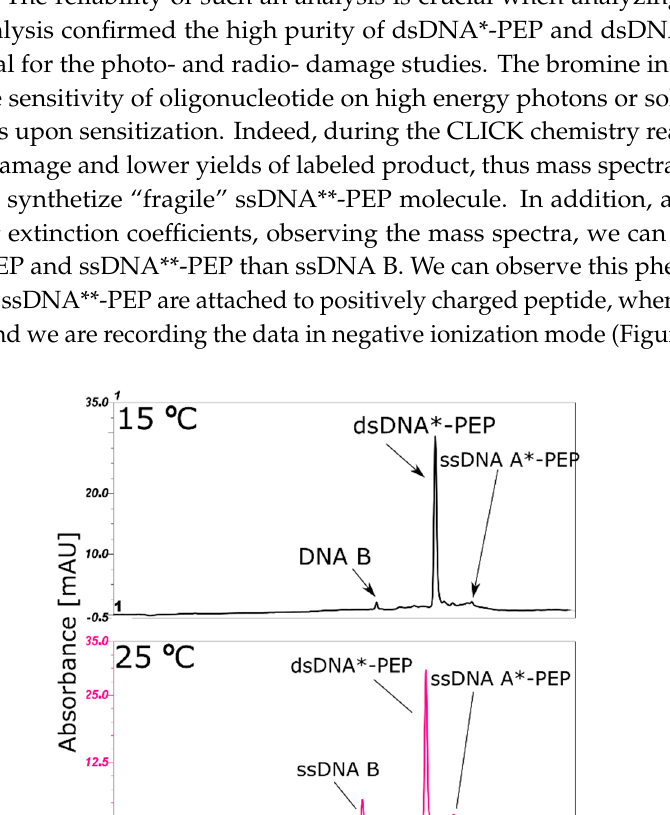
Figure 4. HPLC analysis of the dsDNA*-PEP product obtained after annealing ssDNA A*-PEP peptide conjugates, showing a decrease in the ssDNA form at a lower temperature suggesting the interaction between ssDNA B complementary strand do ssDNA A*-PEP. HPLC conditions: XBridge OST reverse-phase C18 column; mobile phases A: 50 mM triethylamine acetate (TEAA) and 1% acetonitrile in water, B: 80% ACN in water; a gradient of 0–20% / 20 min B was used, maintaining 1 mL / min flow rate; recorded at 260 nm. Molecules 2020 , 25 , x